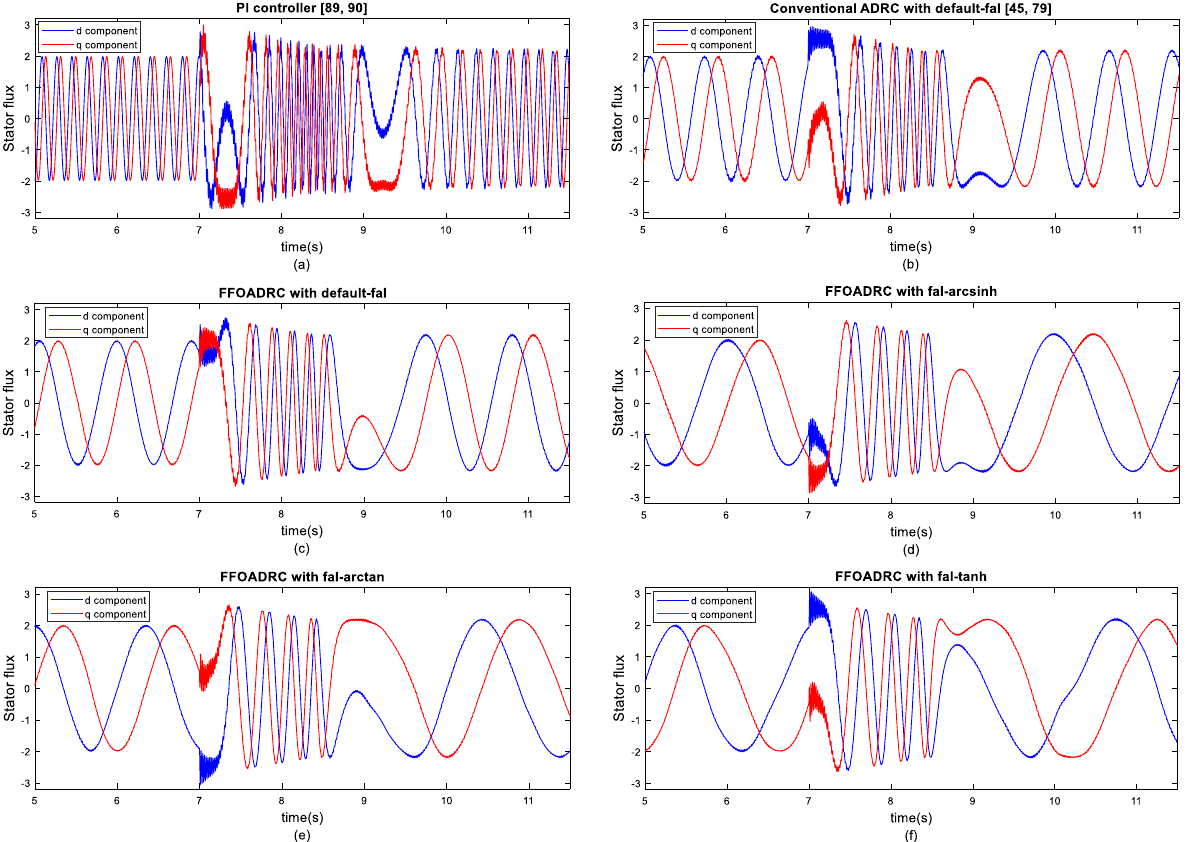
Fig. 27 The d and q components of the stator flux during symmetrical voltage swell: ( a ) PI controller [89, 90], ( b ) Conventional ADRC with default-fal [45, 79], ( c ) FFOADRC with default-fal, ( d ) FFOADRC with fal-arcsinh, ( e ) FFOADRC with fal-arctan, and ( f ) FFOADRC with